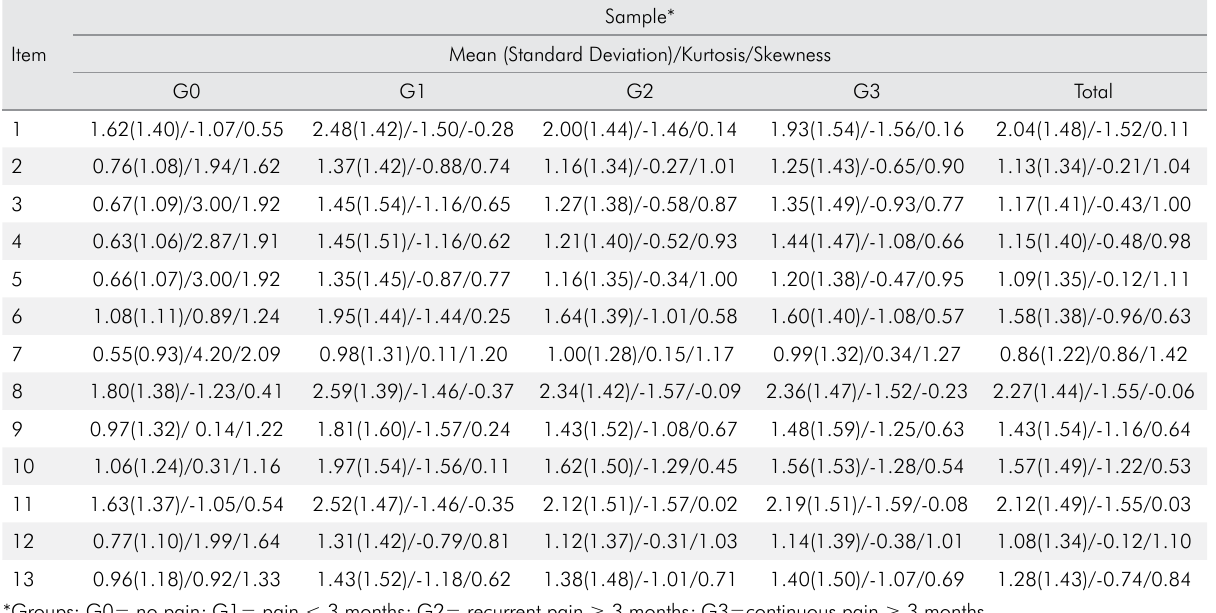
Table 3. Descriptive statistics (mean and standard deviation/kurtosis/skewness) of participants’ responses to the items on the Pain Catastrophizing Scale according to